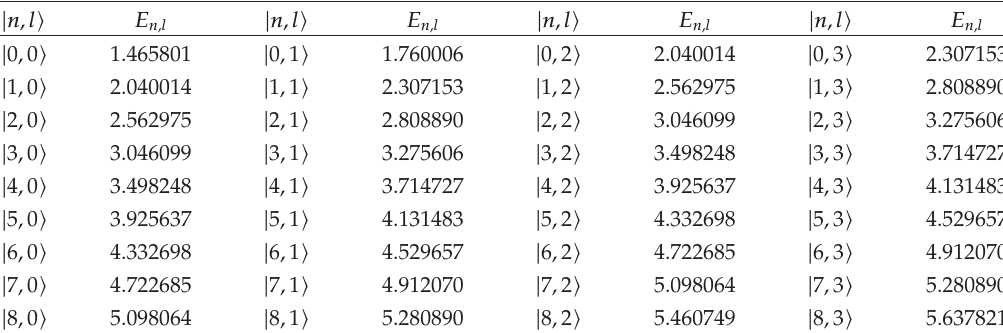
Table 2: Energy eigenvalues for harmonic oscillator with (cid:3) m 0 (cid:9) 1, α (cid:9) 0 . 1 (cid:5)